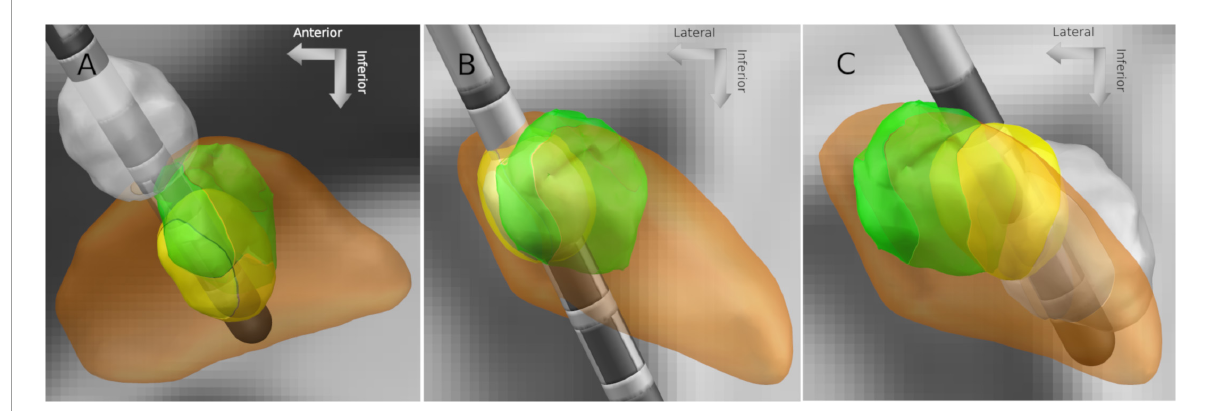
FIGURE5 VTAs of suggested best contact and clinically best contact for three different leads (A–C) . Gray: clinically best stimulation setting; yellow: suggestion by the instant analytical spheres algorithm; green: sweet spot; and orange: subthalamic